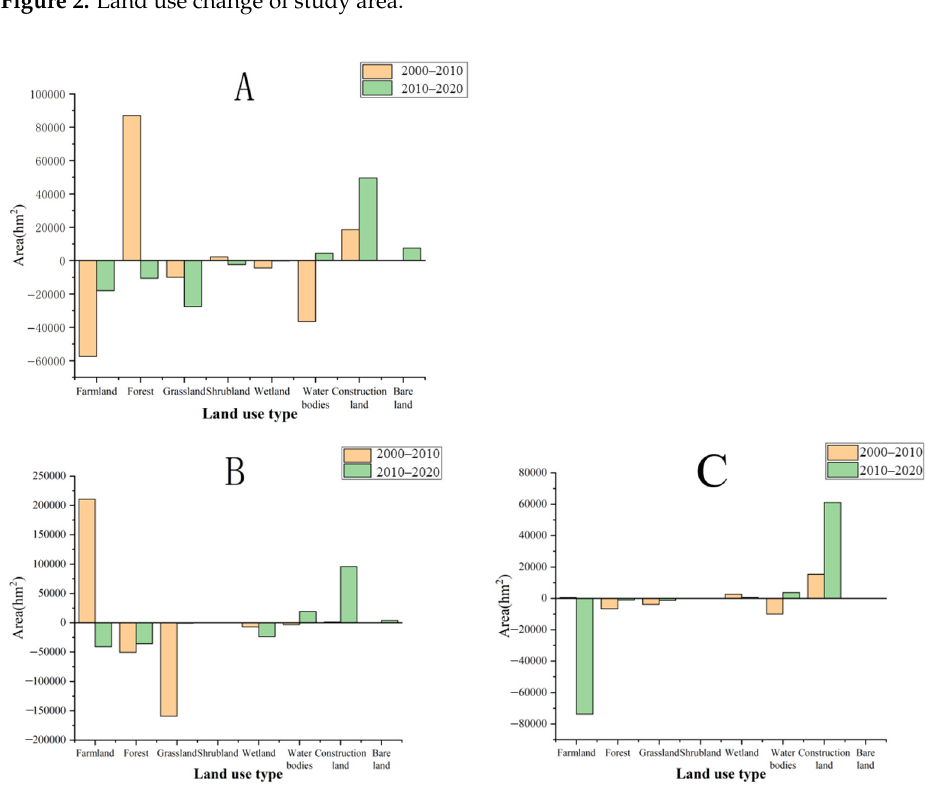
Figure 3. The land use change of subregions during 2000–2020 (( A ): Red River Delta; ( B ): Central coastal area; ( C ): Mekong River Delta;).